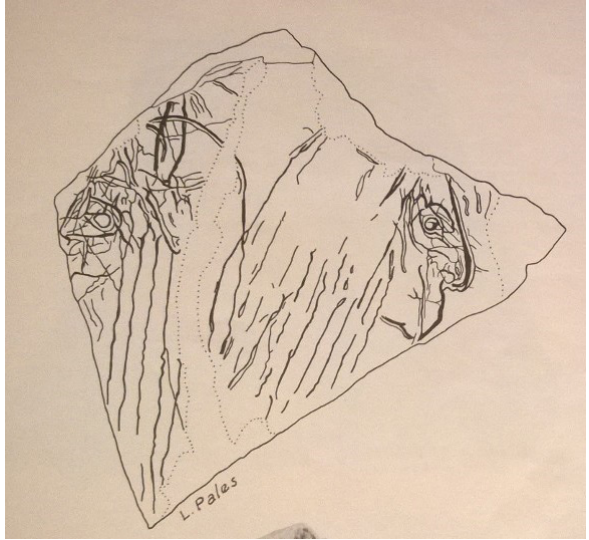
Figure 14. Group α, examples of Hand α5: Obs. 24(I-II) (from Pales,